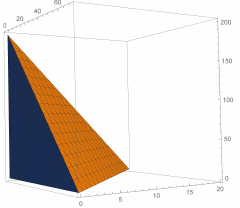
whose vertices are v 0 = (0 0 0) T , v 1 = (38 0 0) T , v 2 = (0 10 0) T , v 3 = (0 0 200) T . This polytope is shown in Figure